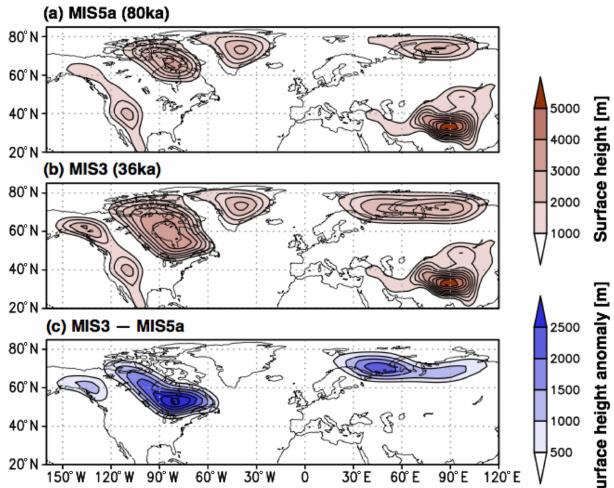
Figure 2. Topography of (a) MIS5a (80ka) and (b) MIS3 (36ka). Results from an ice sheet model are presented (Abe-Ouchi et al., 2013). These ice sheet configurations are used for climate model